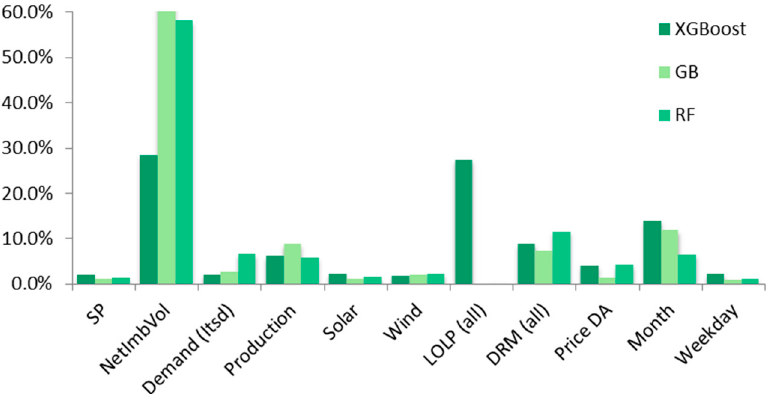
Figure 5. Feature importance of each predictor for all three algorithms XGBoost, Gradient Boosting (GB) and Random Forest (RF).